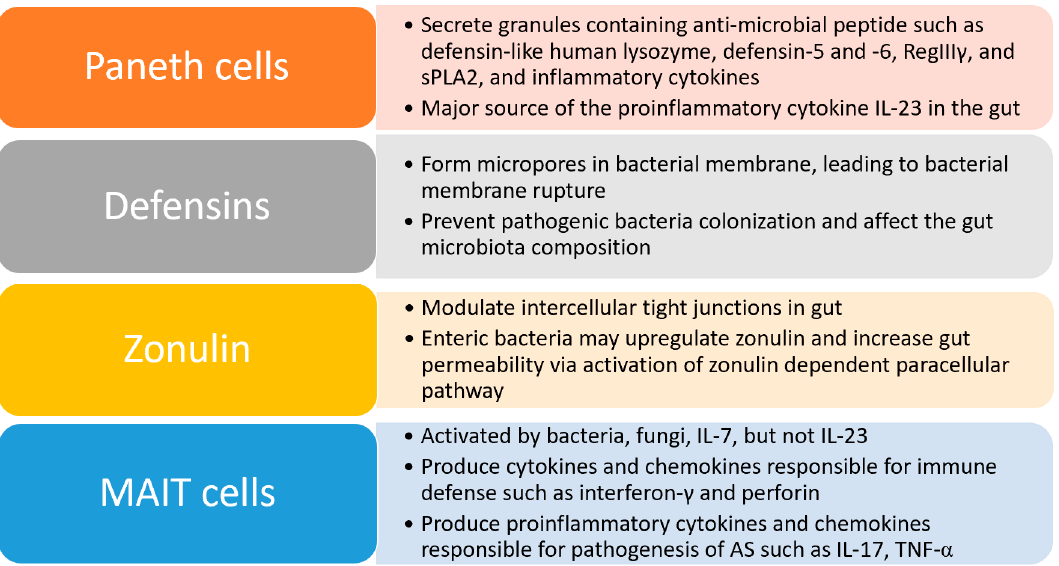
Figure 1. Key mechanisms in regulating gut barrier integrity.